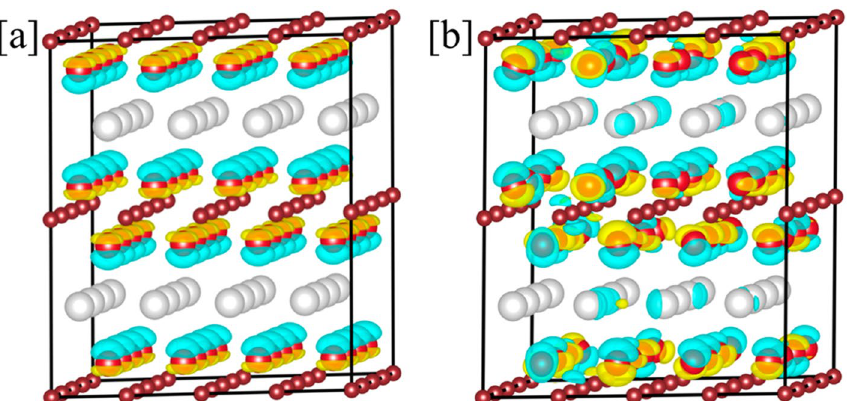
Figure 11. The charge density difference (Δρ) for ( a ) ρ (x = 1.0)–ρ (x = 0), and ( b ) ρ (x = 1.0)–ρ (x = 0.50) in